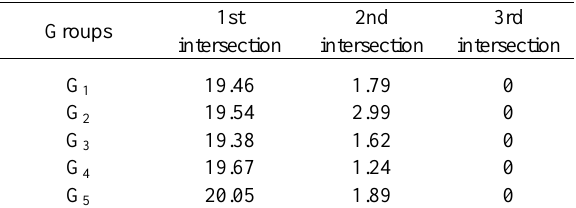
Table 1. One subkey recovery on accuracy by RMSE